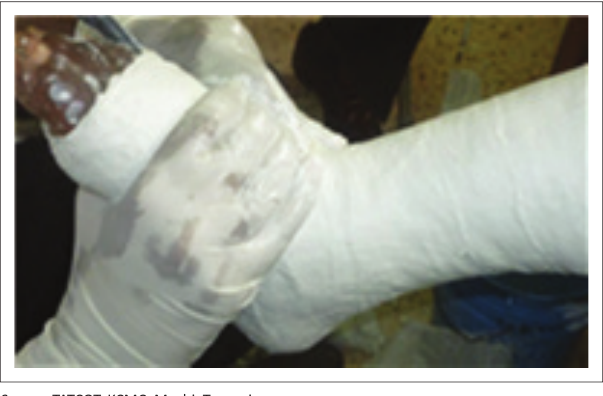
FIGURE 1: Manual casting of a leg with plaster of Paris (POP)